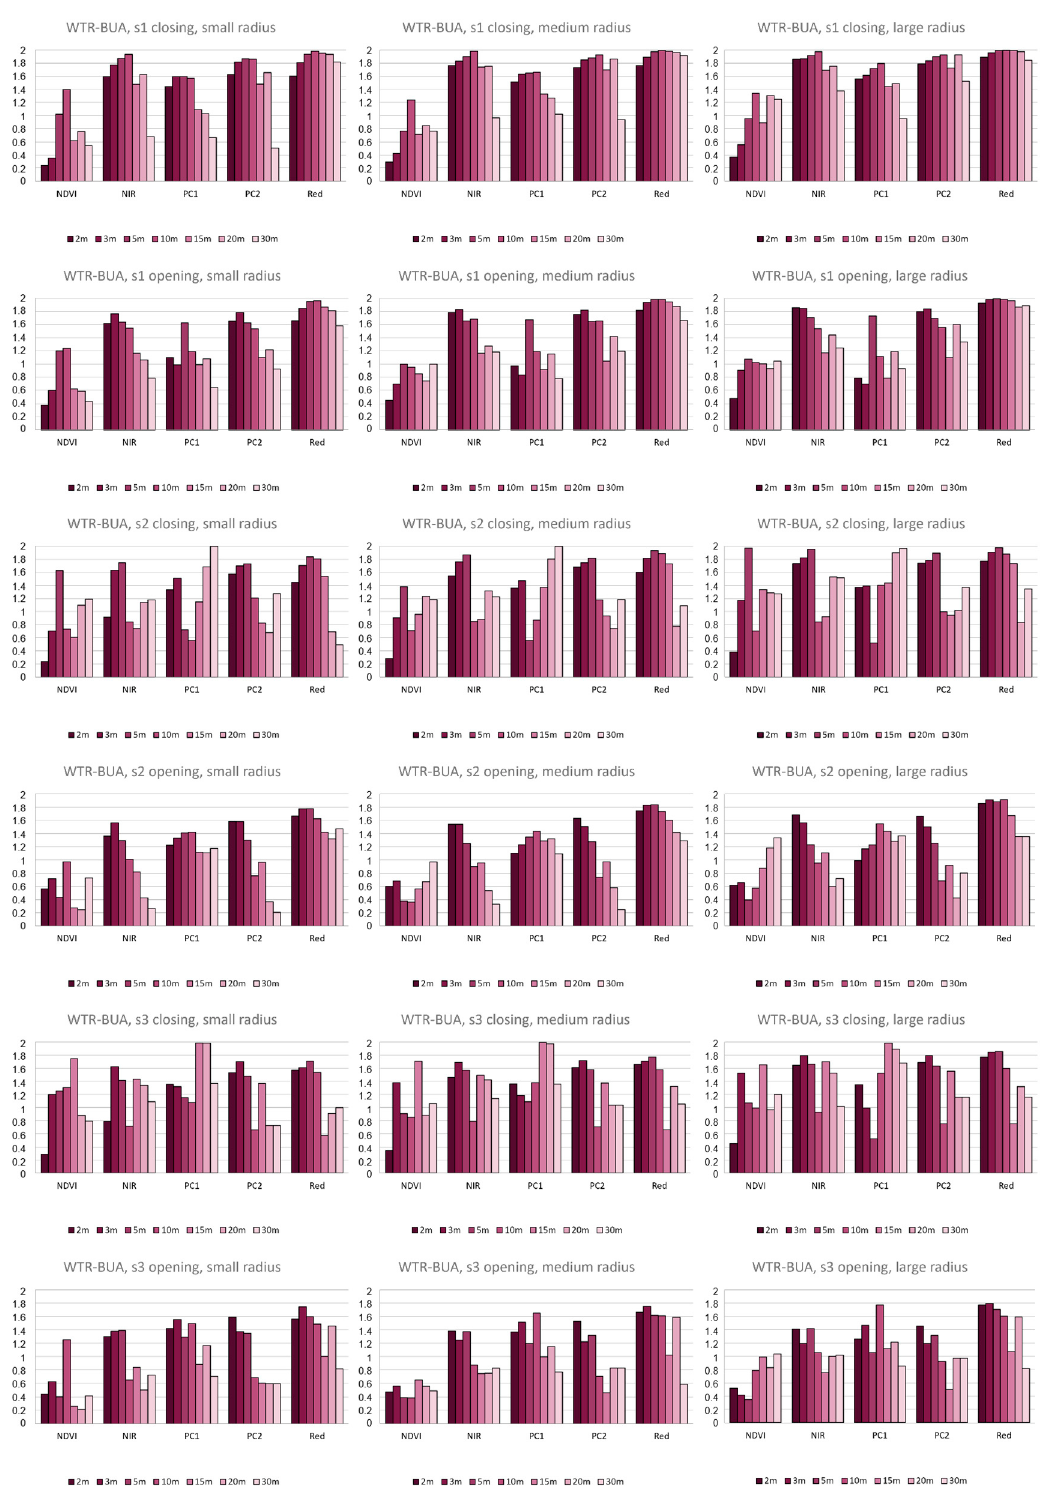
Figure 11. J–M distance diagrams for test fields for the water/built-up area pair (WTR/BUA).